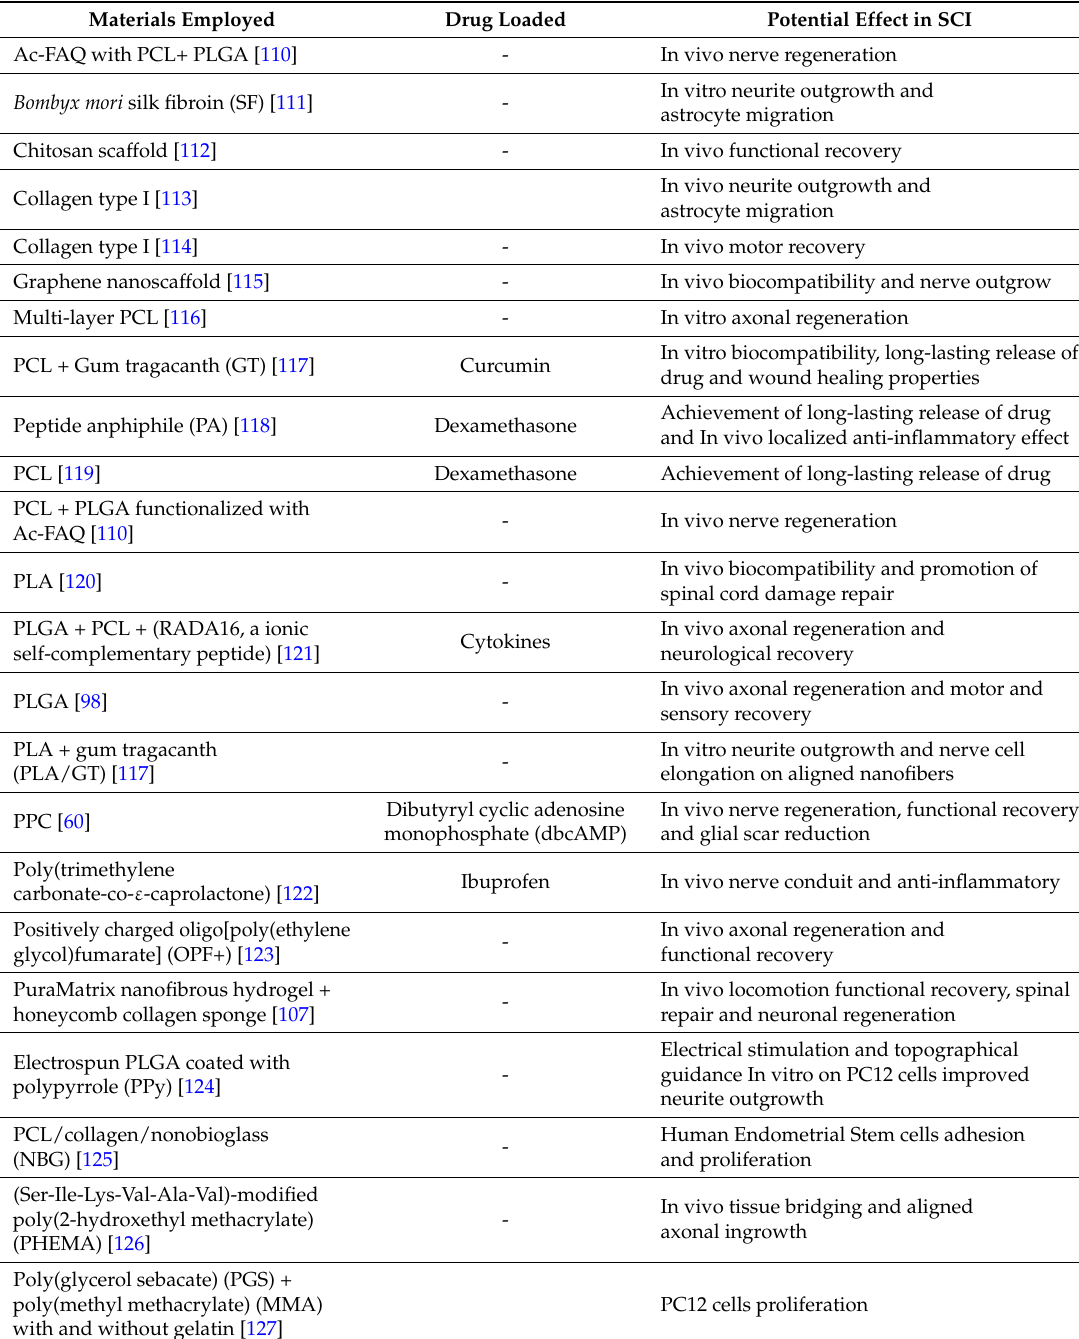
Table 6. Materials employed for production of nanofibers proposed for SCI